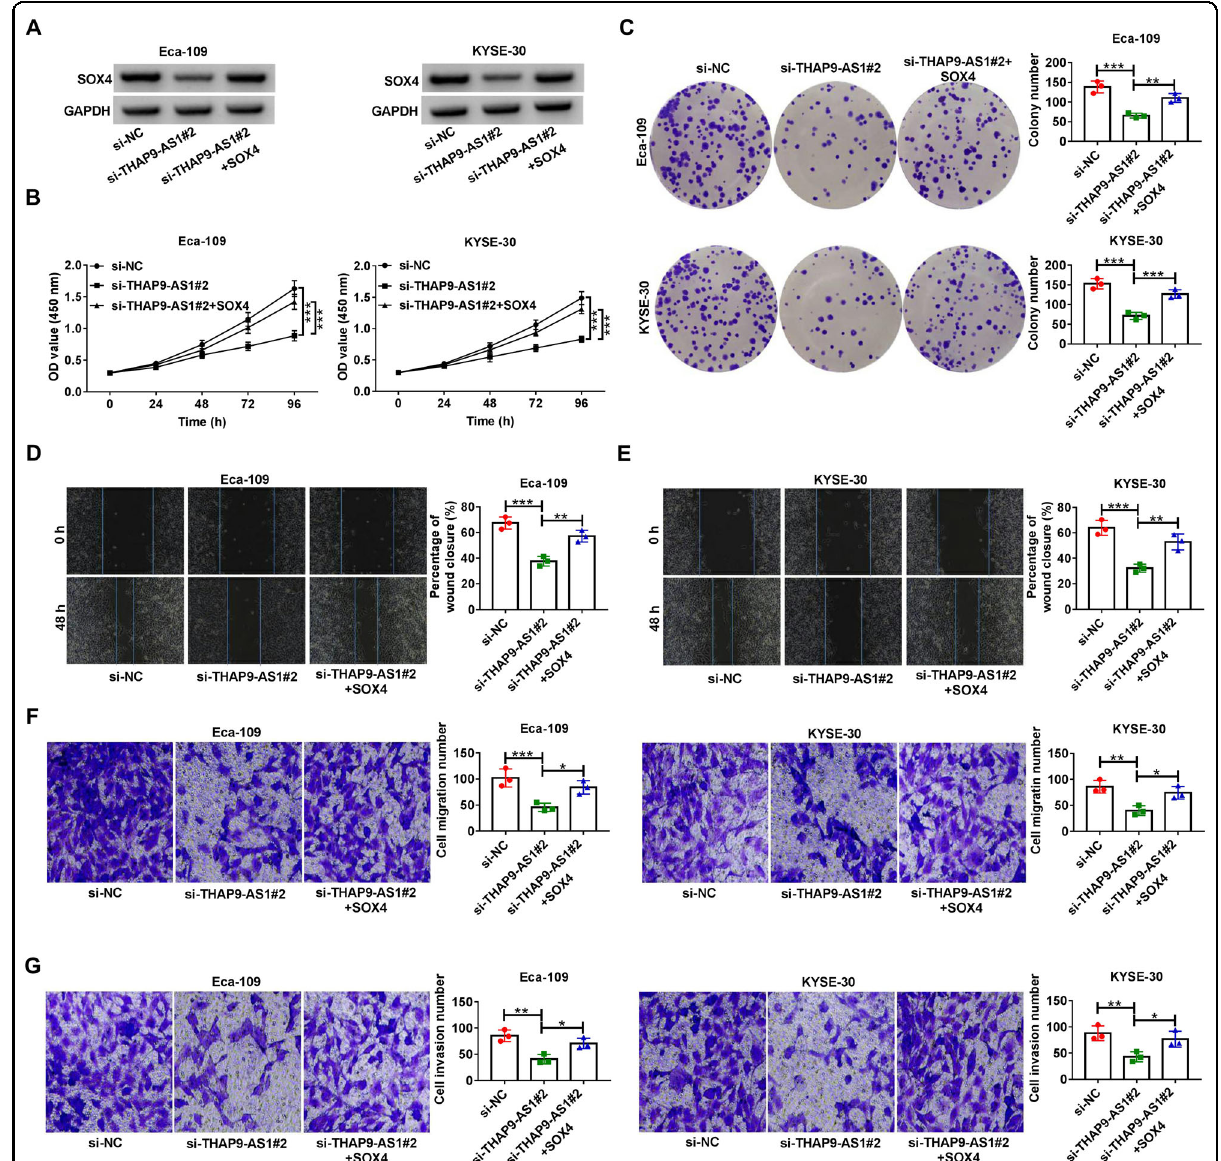
Fig. 6 THAP9-AS1 facilitates ESCC progression in vitro via modulating SOX4 expression. A – G Eca-109 and KYSE-30 cells were transfected with si-NC, si-THAP9-AS1#2 or si-THAP9-AS1#2 + SOX4, followed by western blot assay of SOX4 protein expression ( A ), CCK-8 assay of cell viability ( B ), colony formation assay ( C ), wound healing assay of cell migration ( D and E ), and transwell assay of cell migration and invasion ( F and G ). * P < 0.05, ** P < 0.01, *** P <